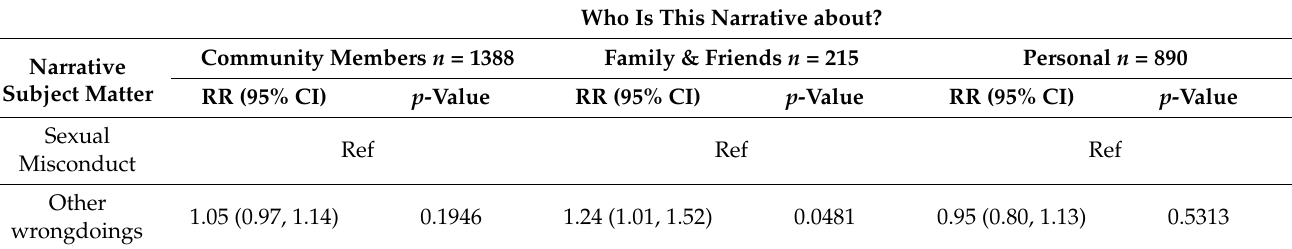
Table 6. Comparison between narratives addressing peacekeeper misconduct or not and the probability of rejecting the UN/MINUSTAH stratified by who the narrative is about. Who Is This Narrative